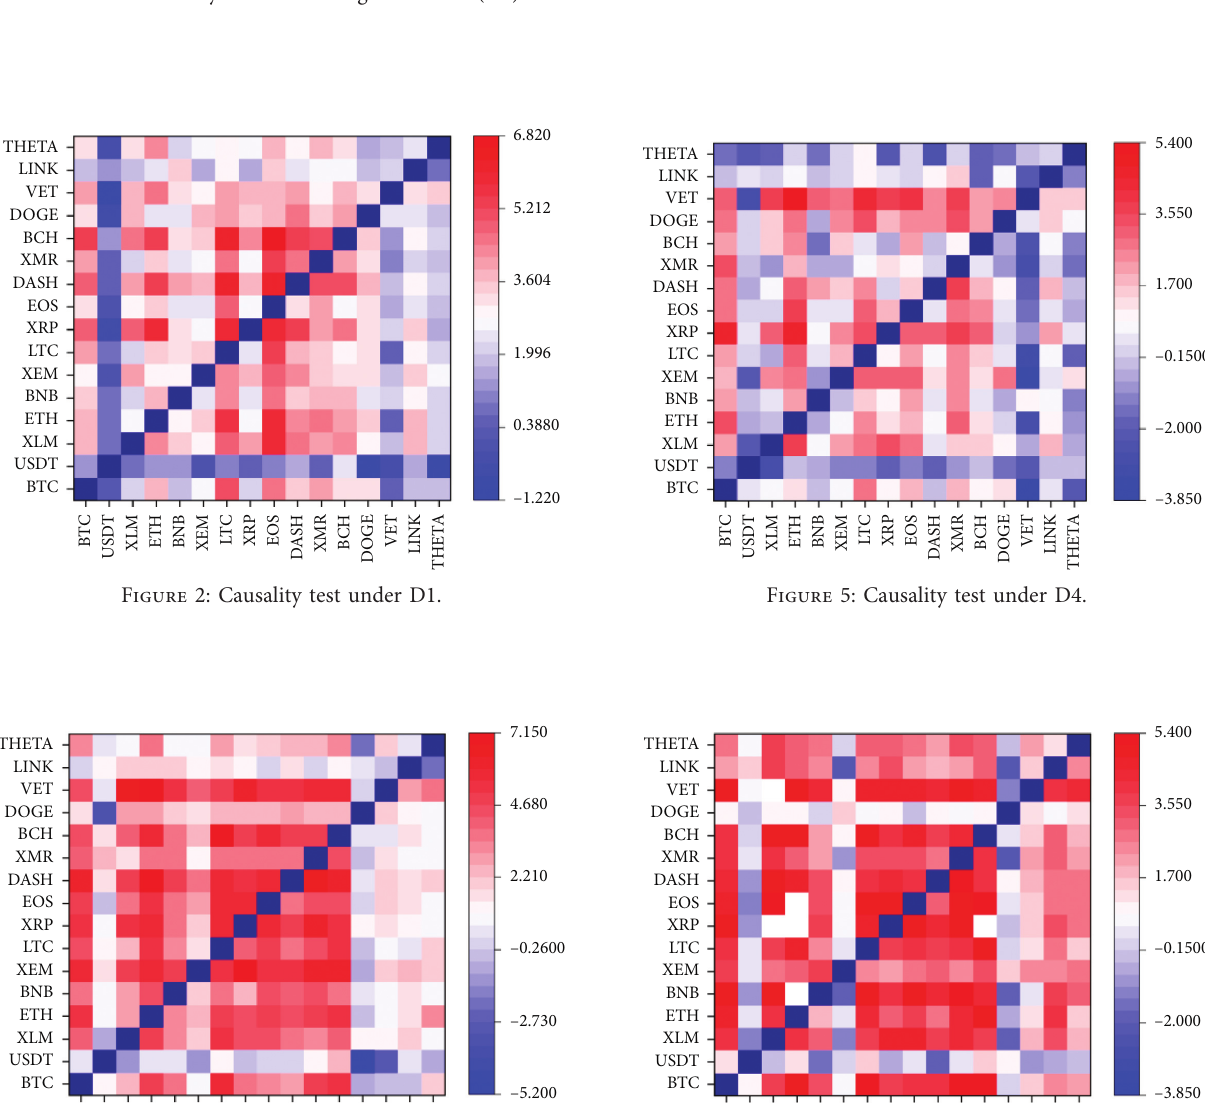
Figure 4: Causality test under D3.